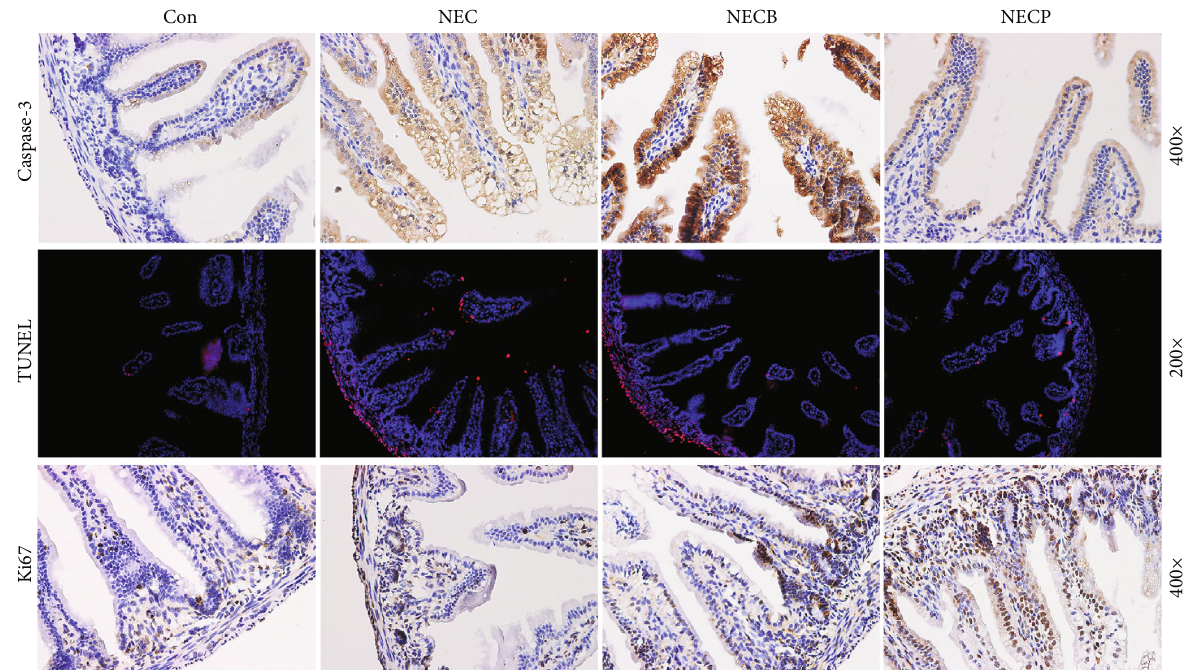
Figure 6: Inhibition of A R by PSB1115 decreased apoptosis but promoted epithelial cell proliferation. Cell apoptosis in intestinal tissues 2B was determined by IHC staining for caspase-3 (a) and TUNEL assay (b). In addition, Ki67 staining was performed to assess cell proliferation. NEC: necrotizing enterocolitis; NECB: necrotizing enterocolitis+BAY60-6583 treatment; NECP: necrotizing enterocolitis +PSB1115